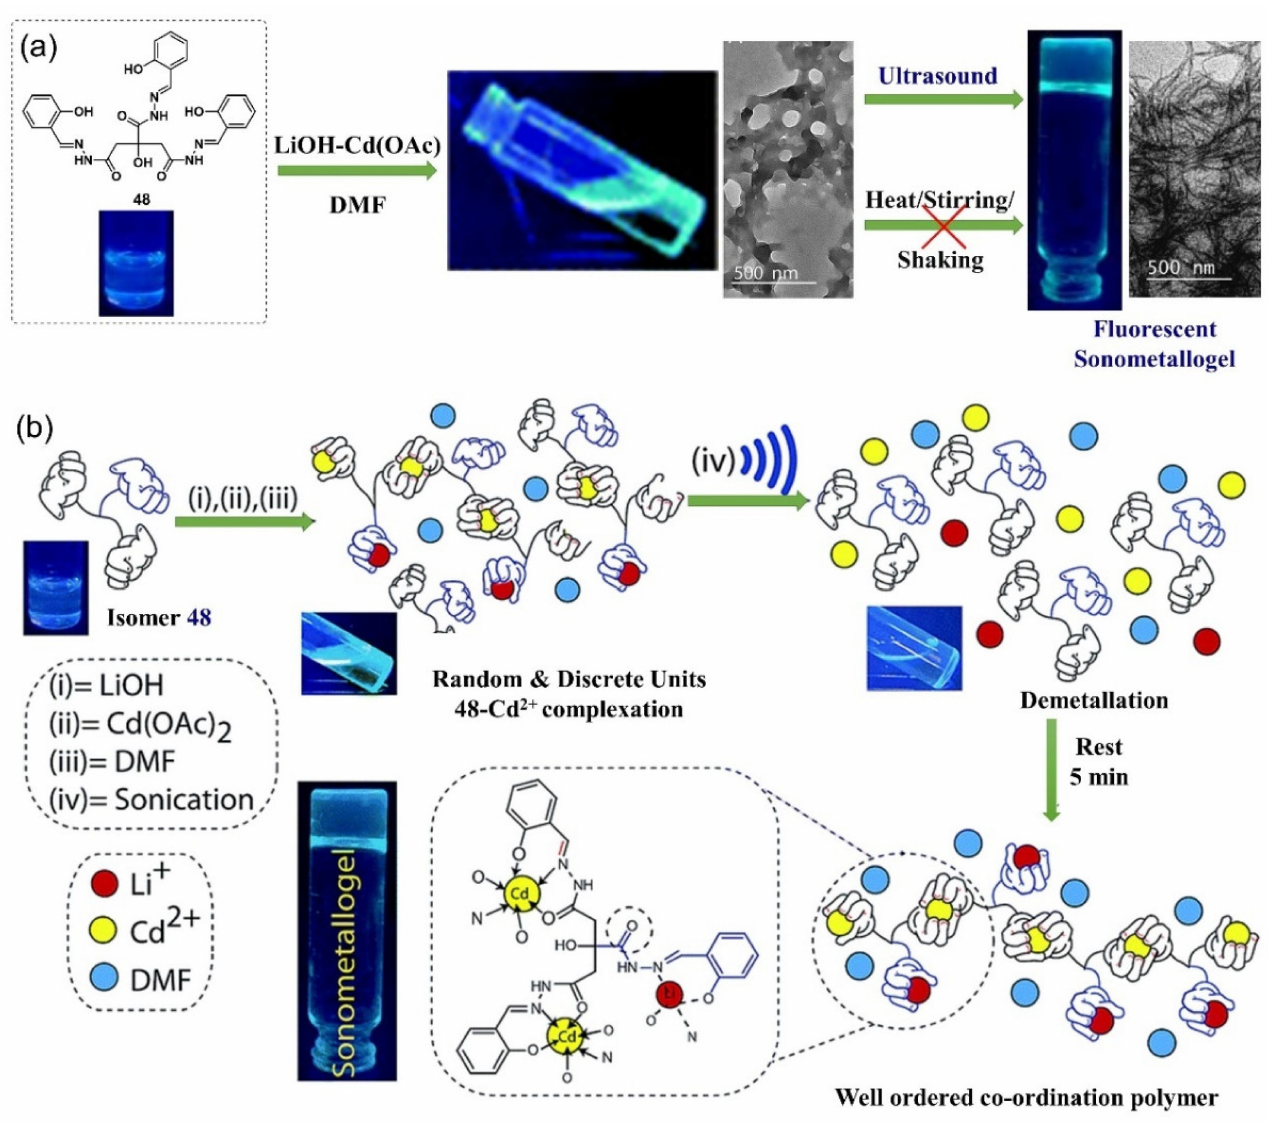
Figure 22. ( a ) The chemical structure of the ligand 48 and the photographs and morphologies of the formed metallogel. ( b ) Model depiction of steps involved in sonometallogel formation along with the binding mode of the ligand 48 . Reprinted with permission from Ref. [85]. Copyright (2017), Royal Society of